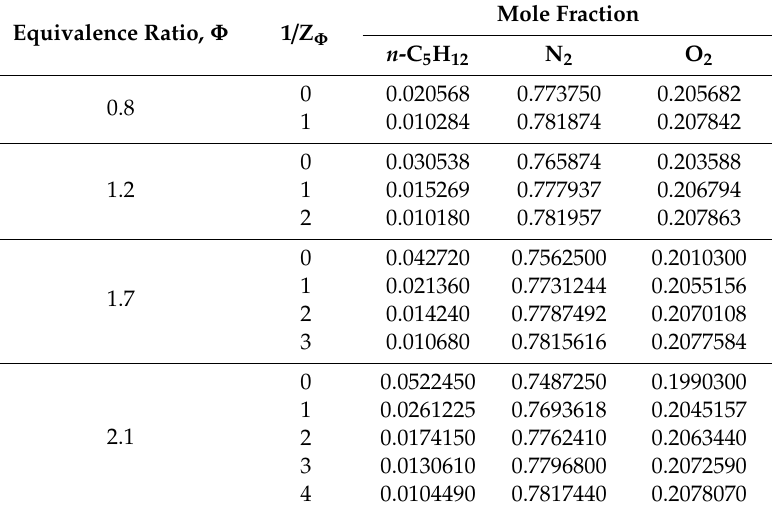
Table 1. The computational cases of air–light hydrocarbon mixing gas and air combustion. Equivalence Ratio, Φ 1 / Z Φ